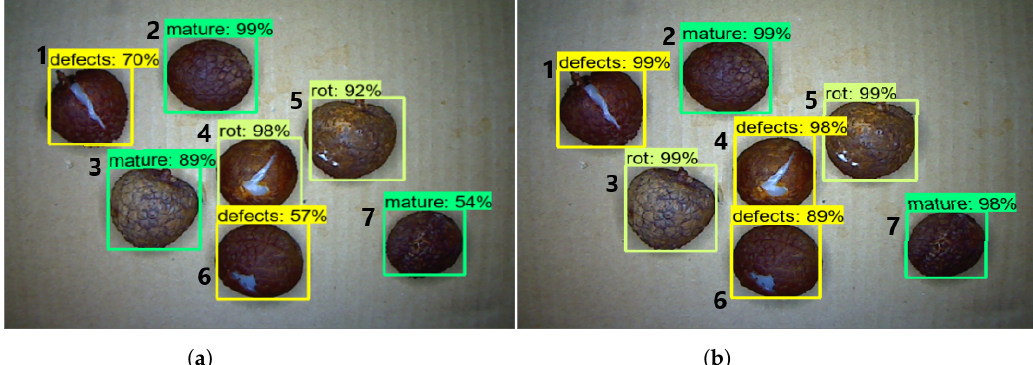
Figure 11. Detection by ( a ) SSD-MobileNet V2 w/base setting and ( b ) SSD-MobileNet V2 w/GAN-based